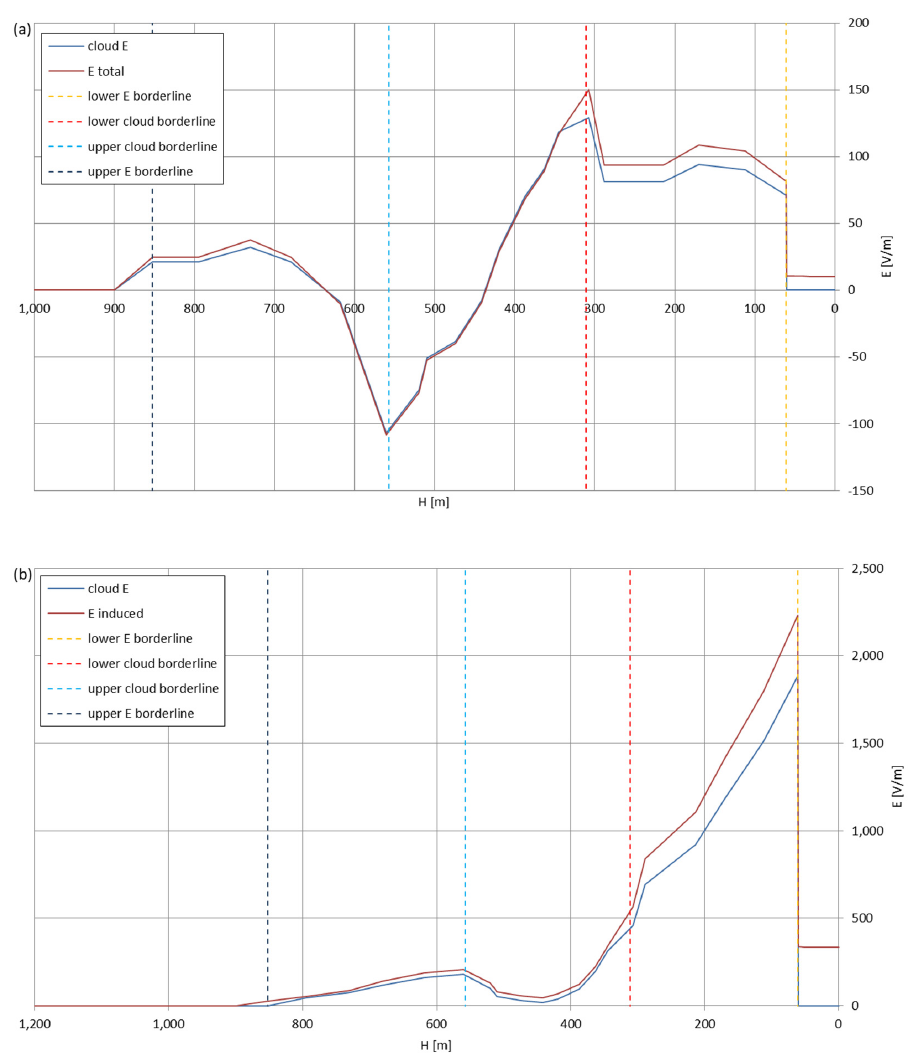
Figure 15. Maximum electric field strengths around the wire antenna re-entering through Stratocumulus cloud charged positively: ( a ) ‘static’ case and ( b ) ‘dynamic’ case.